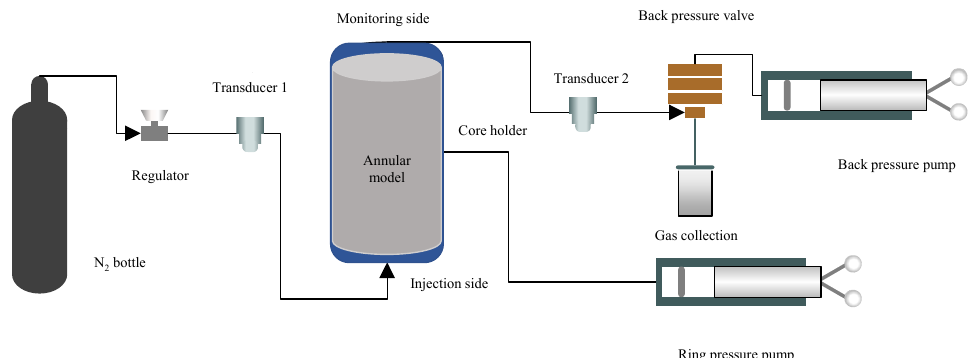
Figure 6. Test flow of cement sheath sealing ability .